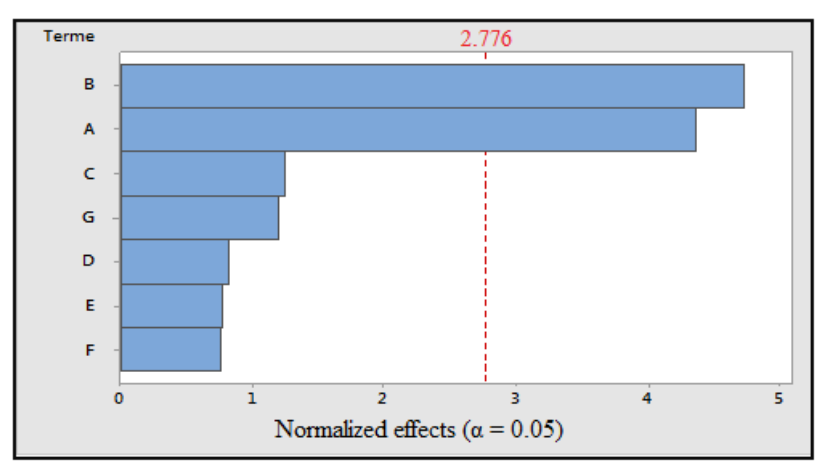
Figure 3. Pareto diagram of normalized effects (α = 0.05); A: cooking time; B: cooking temperature; C: volume of cooking water; D: concentration of solvent; E: maceration time; F: ultrasonic time; and G: grinding.